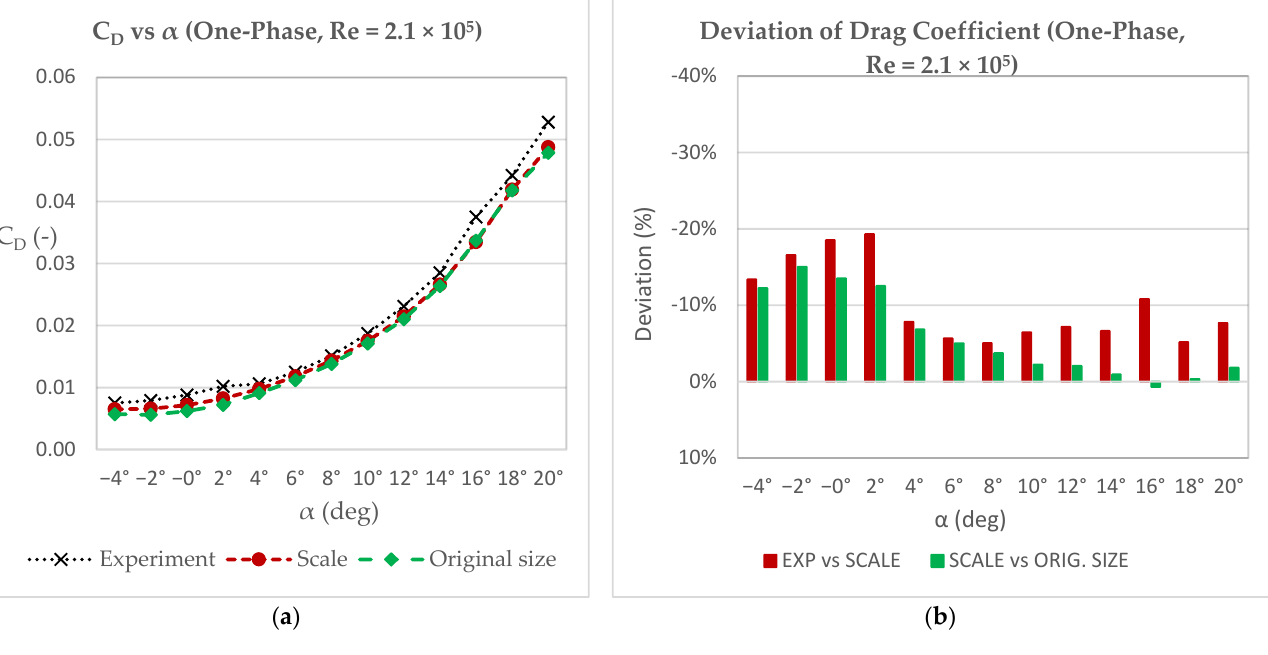
Figure 8. One-phase flow: ( a ) drag coefficient of wing, from numerical simulations of original model and downscaled model, as well as from wind-tunnel experiment; ( b ) deviation of drag coefficient between experiment and downscaled model simulation and between original and downscaled model simulation.